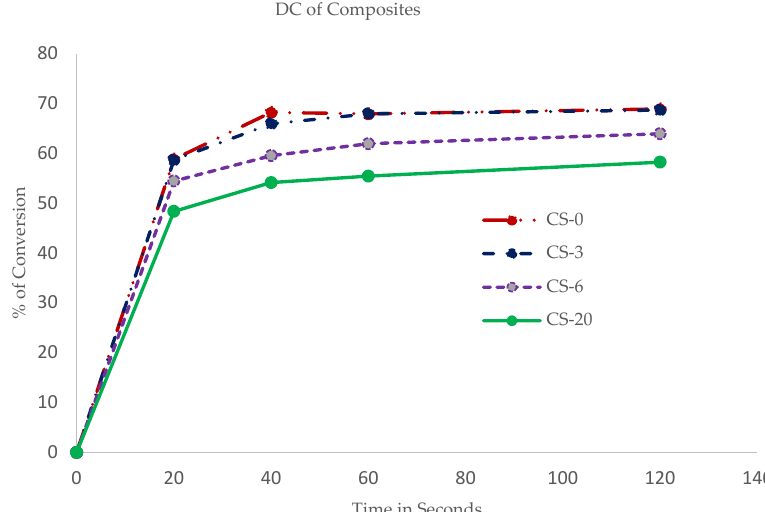
Figure 2. Degree of conversion of composites with respect to time of irradiation shows decreasing conversion rates with increasing percentages of MCP.